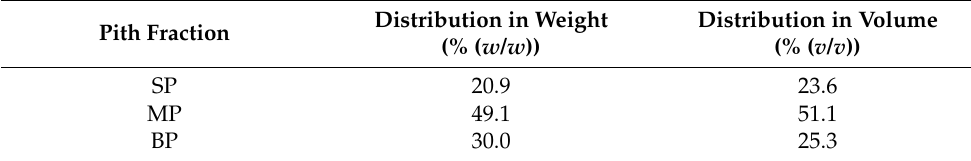
Table 5. Distribution in weight (% ( w / w )) and distribution in volume (% ( v / v )) for the SP, MP, and BP fractions of pith particles, calculated in proportion to the total weight or to the total volume, respectively, of the mixture made of these three pith fractions.